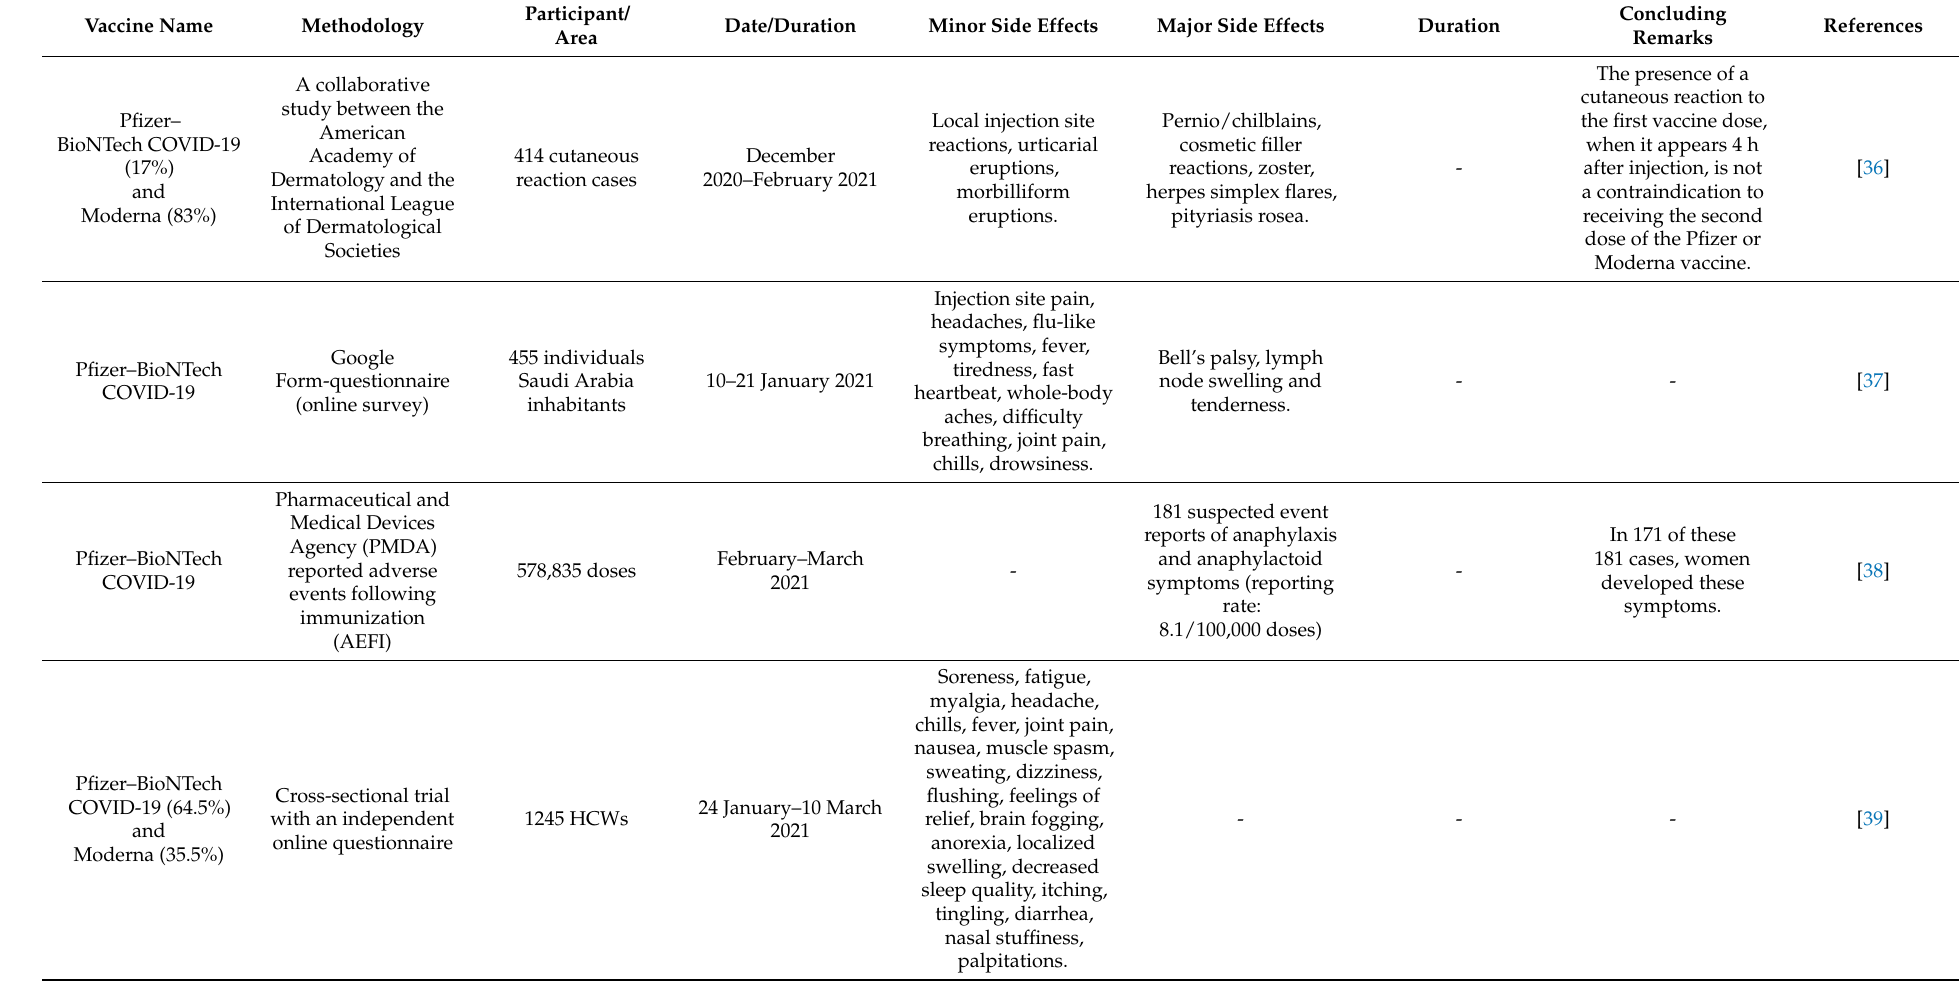
Table 2. COVID-19 vaccinations and their reported